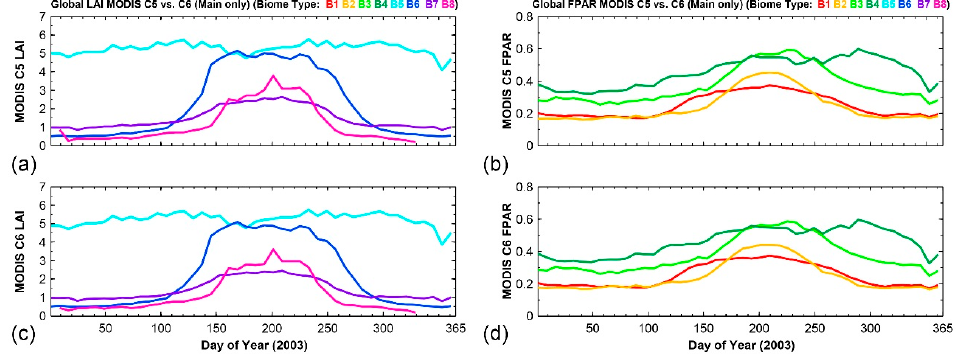
Figure 4. Seasonal variations of globally averaged MODIS ( a ) LAI C5; ( b ) FPAR C5; ( c ) LAI C6; and ( d ) FPAR C6 in 2003. Left panels show seasonal LAI trajectories over four different forest types (evergreen broadleaf forest (B5), deciduous broadleaf forest (B6), evergreen needle leaf forest (B7) and deciduous needle leaf forest (B8)). FPAR panels (right) show other four non-forest biome types (grasses/cereal crops (B1), shrubs (B2), broadleaf crops (B3) and savannas (B4)). LAI of